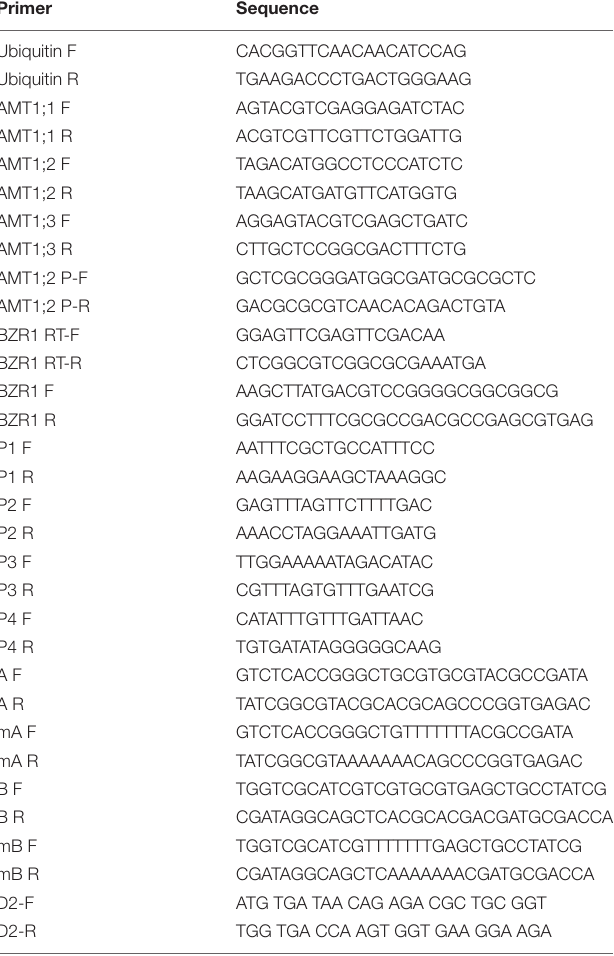
TABLE 1 | Primer sequences used in this study. Primer